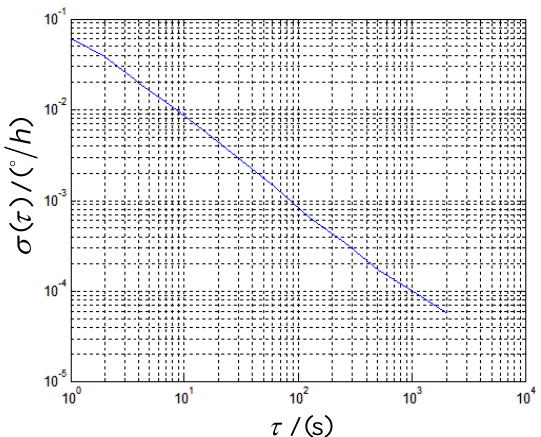
Figure 13. Root Allan variance versus averaging time for gyro in rate-biased mode. The ARW of ω b in rate-biased mode with the angular velocity of 60 gz